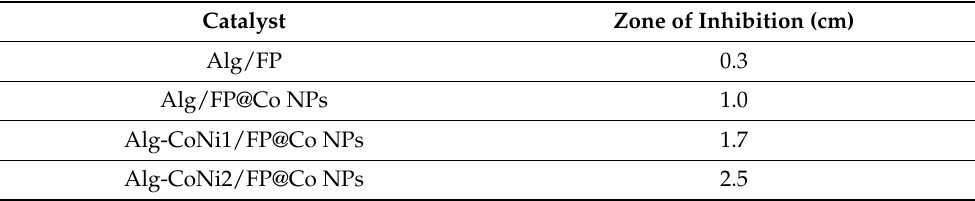
Table 1. Zone of inhibition of B. subtilis by all four catalysts.